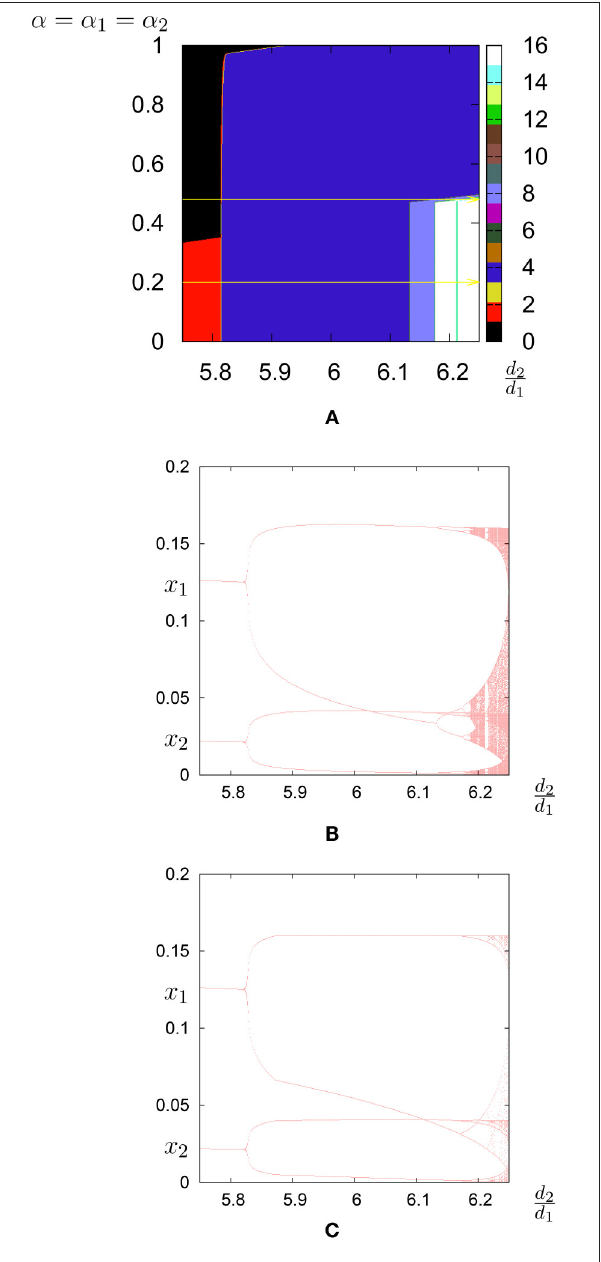
FIGURE 11 | Investment cost. (A) Bifurcation diagram in the parameter d 2 / d 1 , α α 1 α 2 plane ; the regions of different periodicity are = = represented by different colors. The horizontal yellow lines represent the (cid:0) (cid:1) line on which, in (B) , the bifurcation diagram is shown with α α 1 α 2 0.20 and in (C) , the bifurcation diagram is shown with = = = α α 1 α 2 = = =